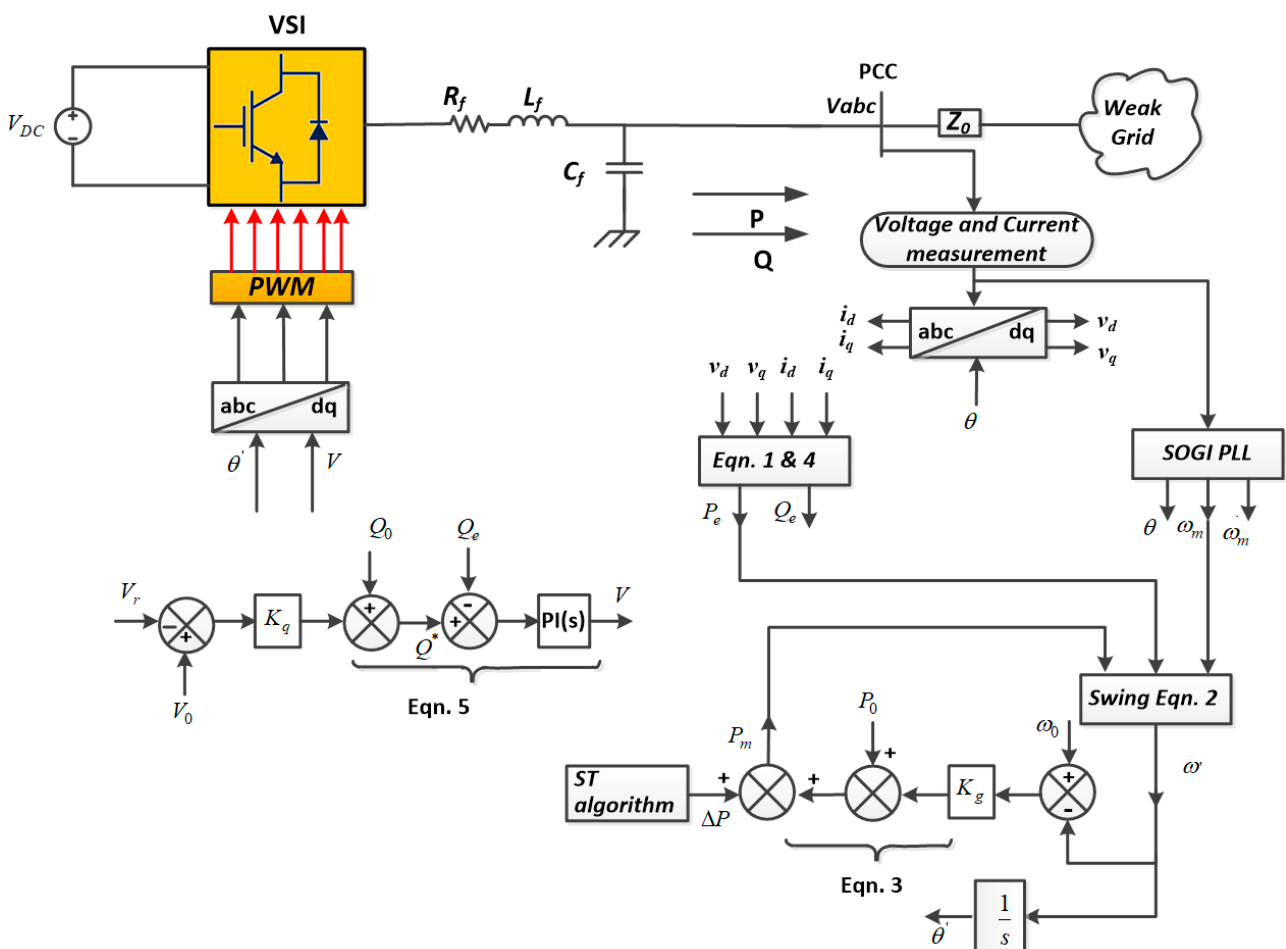
Figure 1. Super-twisting algorithm-based VSG-IIDG.